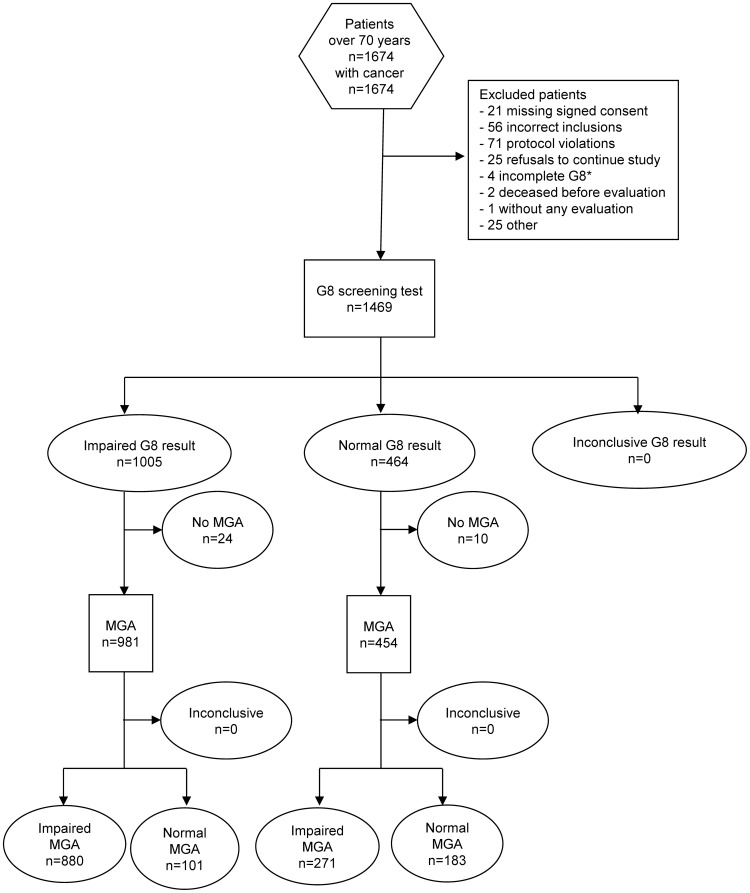
STARD flow diagram for patient enrollments and exclusions in the ONCODAGE G8 study.Footnote: *In total, ten G8 were incomplete, but six ‘abnormal’ scores were able to be imputed from the incomplete assessments.